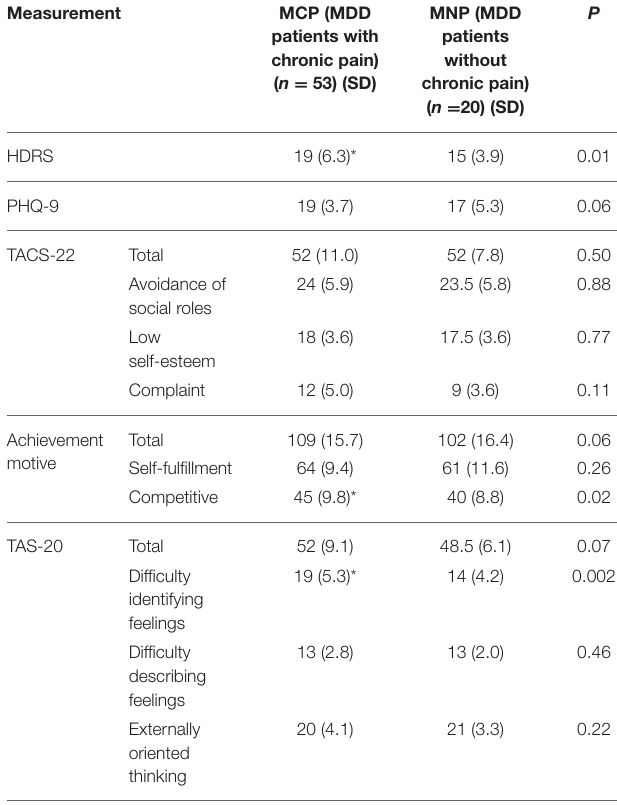
TABLE 2B | Comparison of medians of the MDD Patients ( n = 73). Measurement MCP (MDD